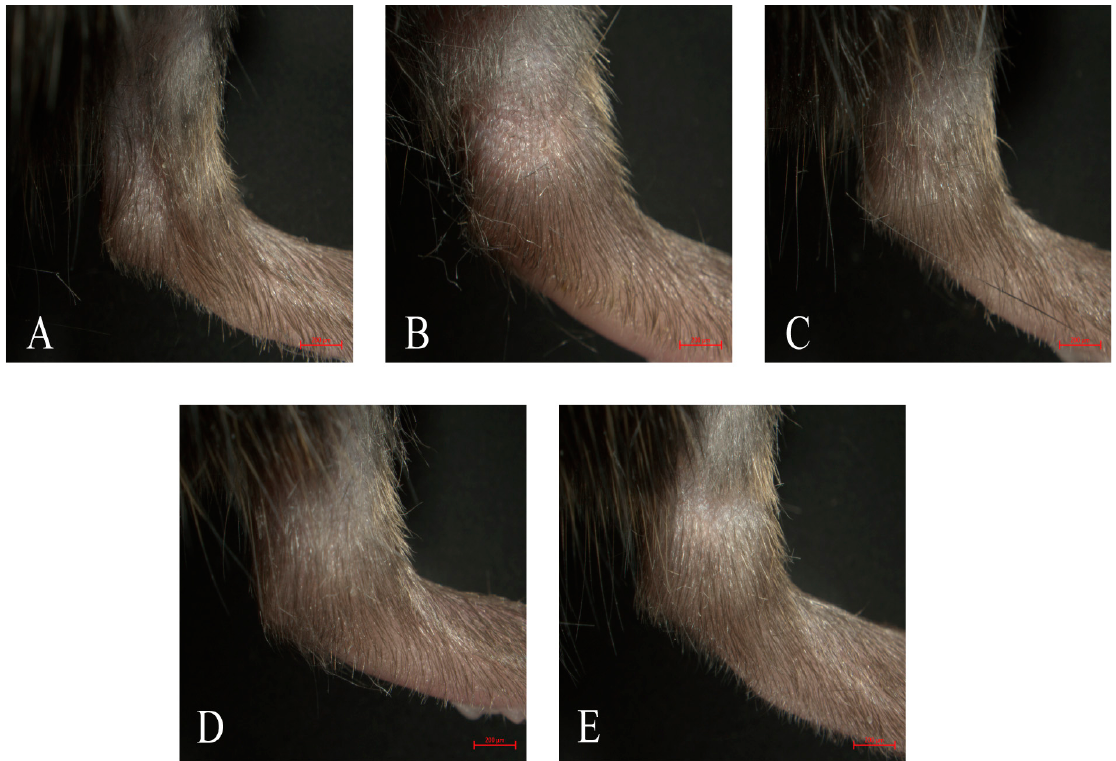
Figure 6. Effect of neoastilbin on MSU-induced ankle swelling in GA mice. Representative photo- graphs of ankles 24 h after MSU injection: ( A ) control group, ( B ) MSU group, ( C ) colchicine group, ( D ) neoastilbin low-dose group, and ( E ) neoastilbin high-dose group.